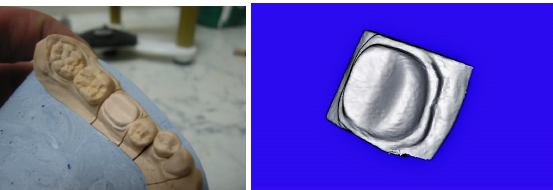
Figure 2. Prepared tooth on stone cast model of the lower dental arch and its 3D image